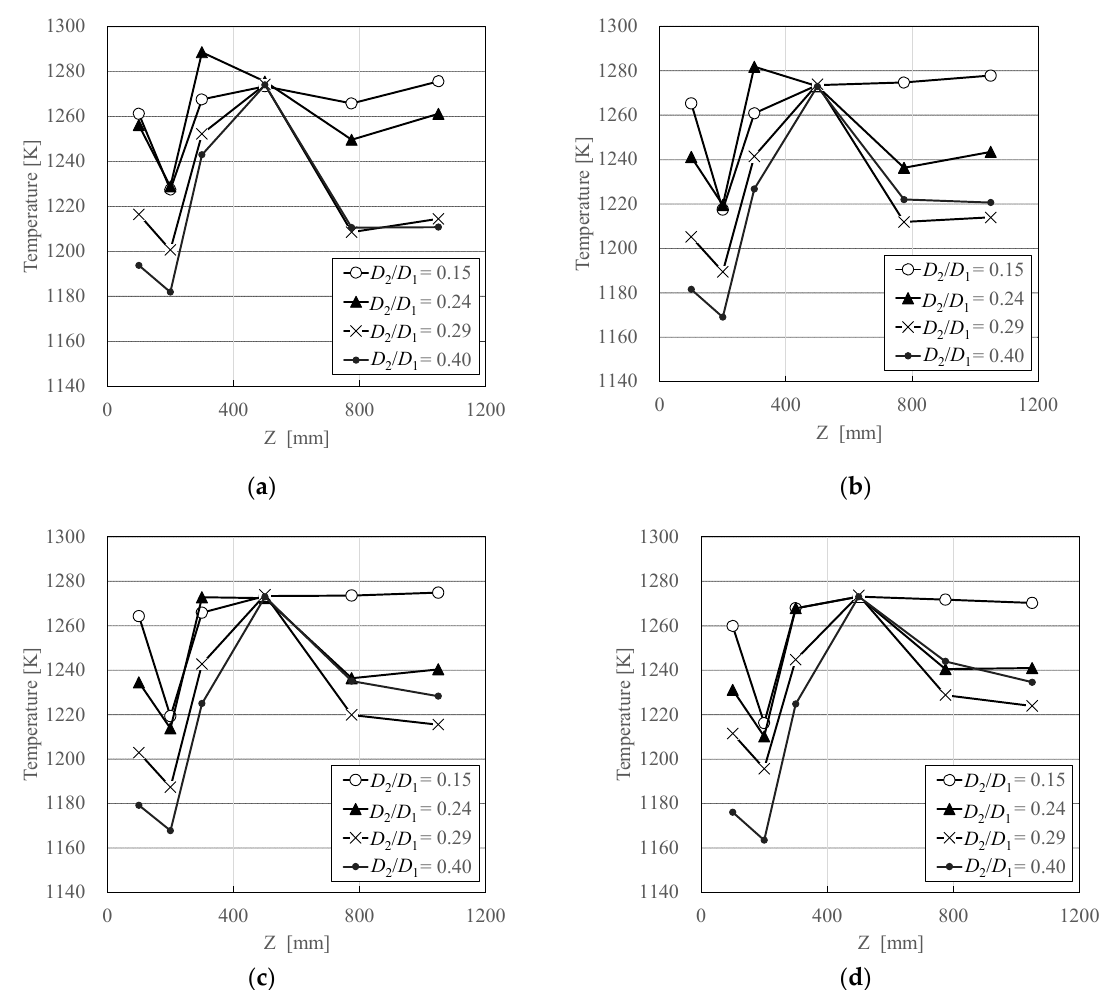
Figure 8. Comparison of temperature distribution for different D 2 / D 1 at ( a ) E NH3 = 10%; ( b ) E NH3 = 40%; ( c ) E NH3 = 60%; ( d ) E NH3 = 80%. Input = 11.63 kW, λ total = 1.2, L = 100 mm.